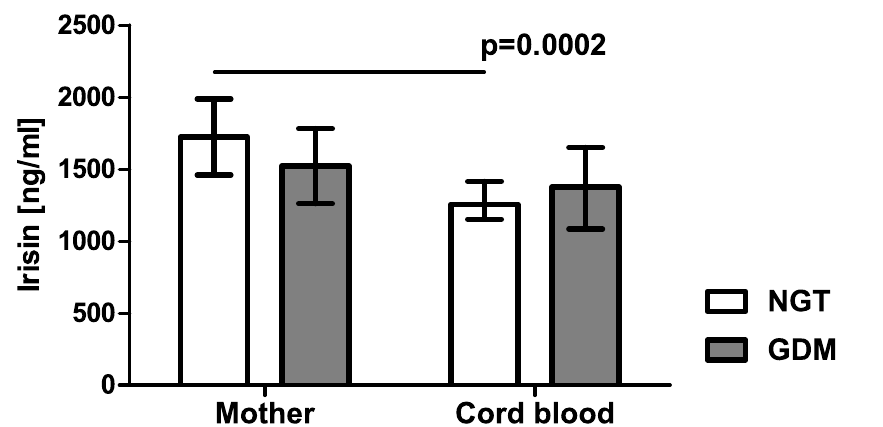
Fig 4. Serum irisin concentration in patients with normal glucose tolerance (NGT) and gestational diabetes (GDM) from Group 2; data were analyzed by Mann-Whitney U test and shown as medians with interquartile